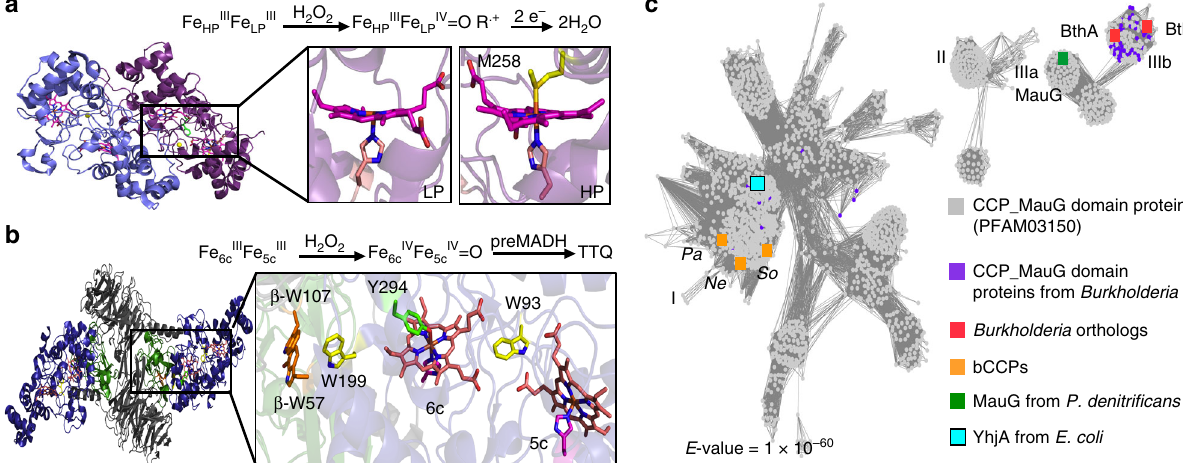
Fig. 1 SSN of CCP_MauG domain containing proteins. a Active site domain of bCCPs. Reaction scheme indicates oxidation states achieved for reaction of bCCPs with H 2 O 2 . Upon addition of H 2 O 2 , a compound I intermediate is formed, where an electron is lost from a nearby tryptophan as is suggested for Ne . Crystal structure of Ne peroxidase (PDB: 1IQC) is shown as dimer (purple). Inset shows structure of the six-coordinate, high potential (HP) heme (right) and fi ve-coordinate, low potential (LP) heme (left). b Active site domain of MauG. Reaction scheme shows overall oxidation state achieved for reaction of MauG with H 2 O 2 in the presence of preMADH. Crystal structure of overall fold of MauG is shown in complex with preMADH (PDB: 3L4M). Inset shows diheme active site of MauG, including key tryptophan residues that are post-translationally modi fi ed in preMADH ( β -W107, β -W57) after reaction with H 2 O 2 . Six-coordinate heme (6c) is shown with Tyr-His ligation. c SSN generated for CCP_MauG containing proteins with E -value = 1.0 × 10 – 60 . Graphical representation of network created using Cytoscape. Main protein clusters, where each node represents and individual sequence, are identi fi ed by roman numerals. Cluster I includes canonical bCCPs, Cluster IIIa includes MauG from P. denitri fi cans and other known orthologs, and Cluster IIIb includes diheme enzymes (BthA and BthB from B. thailandensis are indicated) conserved in